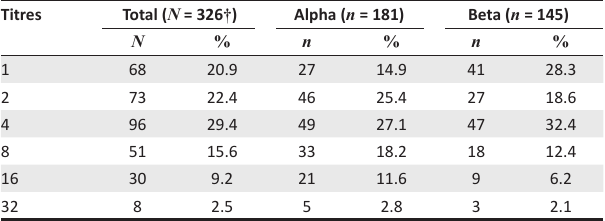
TABLE 3: Titres of alpha and beta haemolysins among blood group O donors at the RHBBB, Cameroon, June 2020–September 2020.